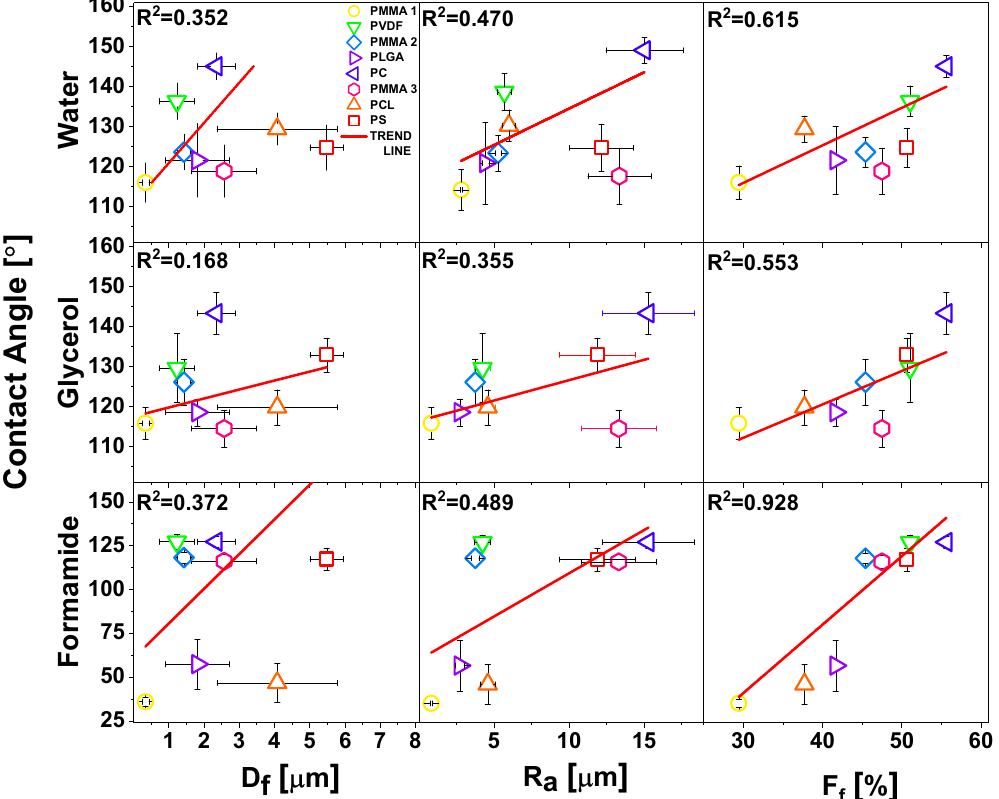
Figure 5. Water, glycerol, and formamide contact angles as a function of fiber diameters, D f roughness R a , and F f . The linear fittings to the experimental points with R 2 values are indicated on the graphs.